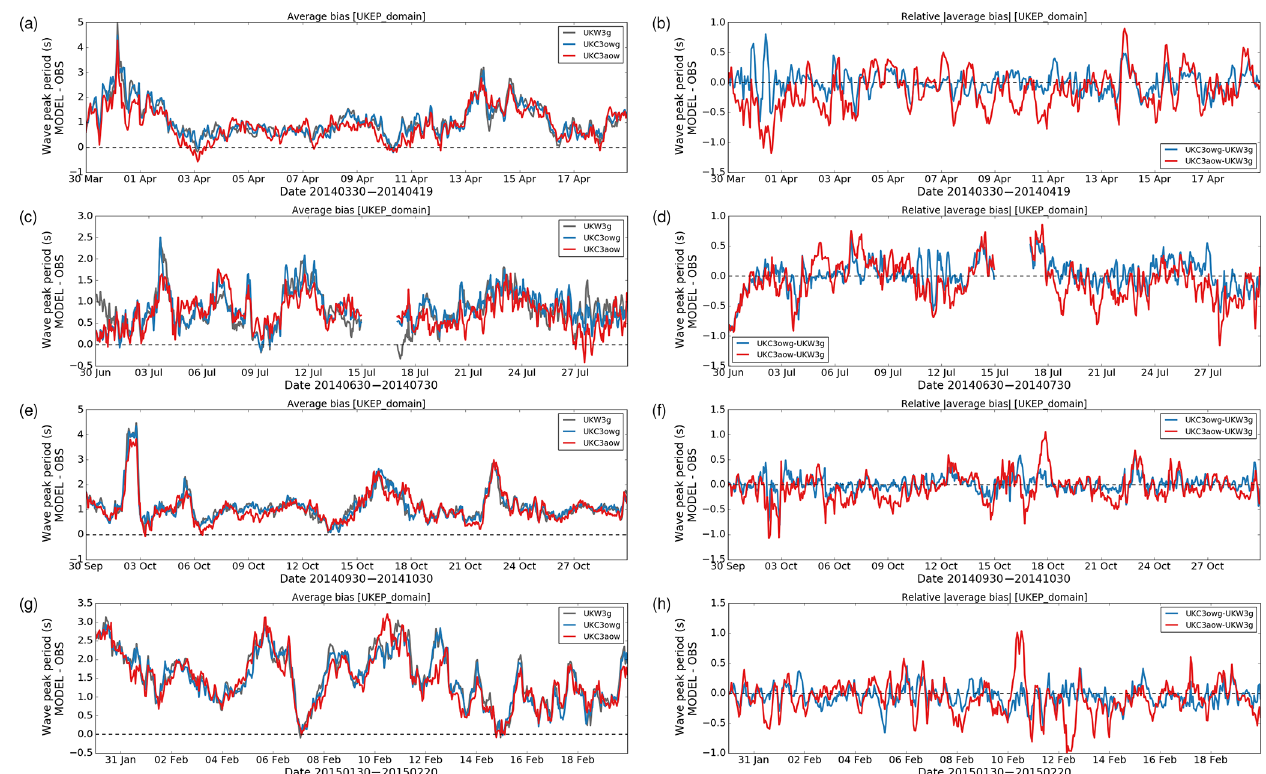
Figure 8. Sensitivity of wave model peak wave period ( T p ) to coupling. (a, c, e, g) Time series of average model–observation (MODEL–OBS) bias across all observing sites for each simulation for July, April, October 2014 and February 2015, respectively. (b, d, f, h) Differences in absolute | MODEL–OBS | bias for each simulation period relative to UKW3g. Note that plots have different scales across the different months evaluated, and observations are compared with a nearest neighbourhood mean of 3 by 3 model grid